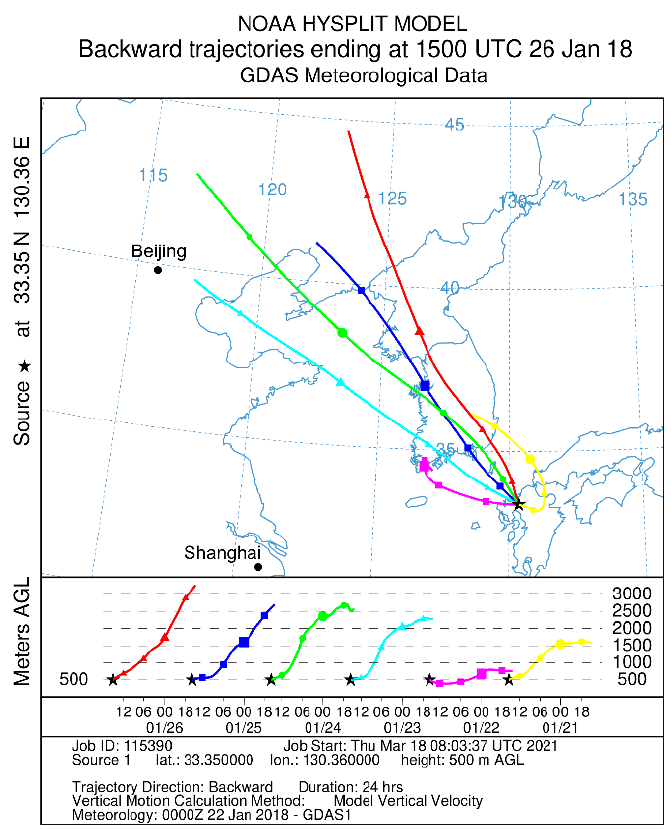
Figure 6. Backward Trajectories from Fukuoka City. Start time is 0:00 (midnight), Fukuoka local time (JST), which is 15:00 UTC. Starting height is 500 m. The upper direction indicates North.